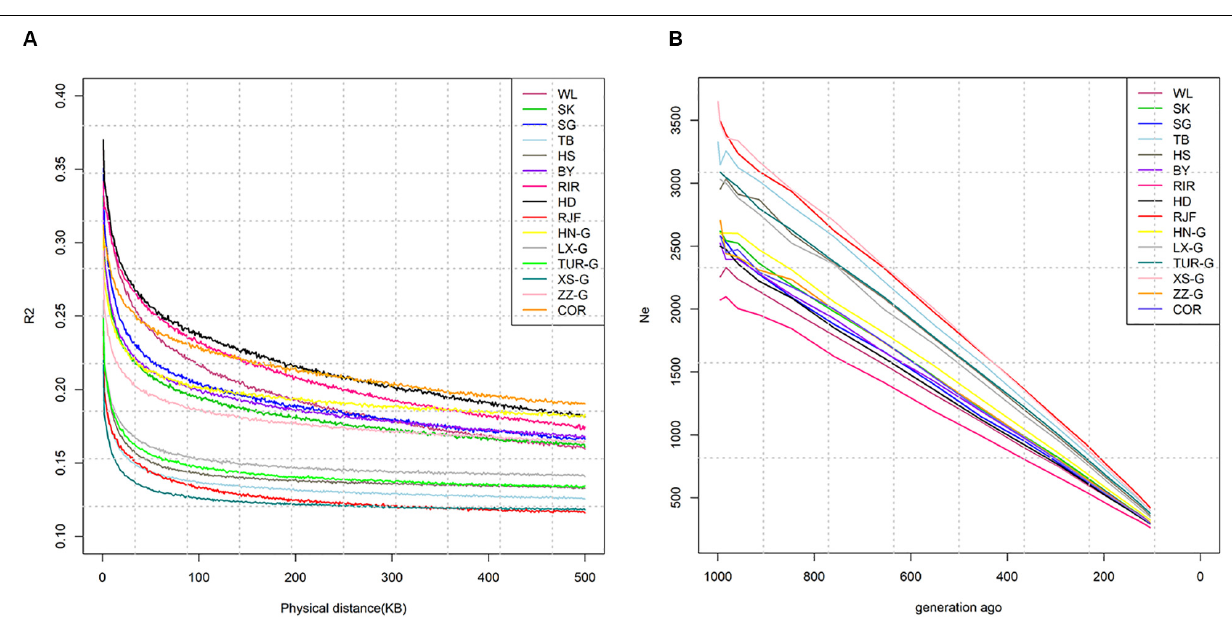
FIGURE 4 | (A) Decay in linkage disequilibrium (r 2 ) over increasing intermarker distance in different population. (B) The trend in modern effective population size of different